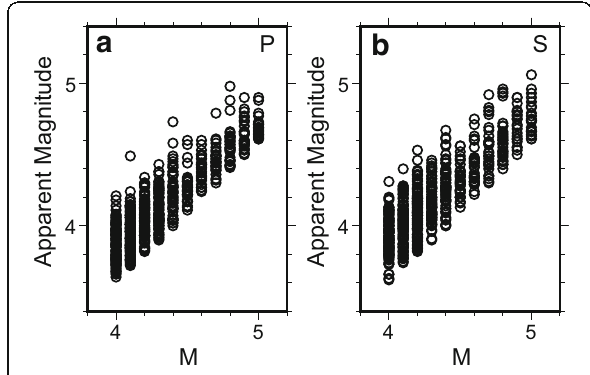
Fig. 7 Relationships of magnitudes determined by JMA and the apparent magnitude derived as the sum of the magnitude of EGF earthquakes (3.5) and values of 2 = 3 ð corresponds to the difference in magnitude between the analyzed and EGF earthquakes if their focal mechanisms are identical. a and b show the results for P and S waves,